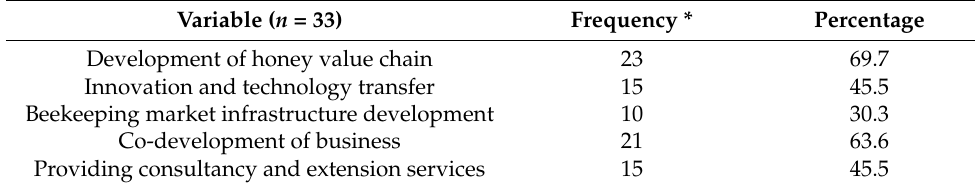
Table 8. The purpose of the partnerships investigated.